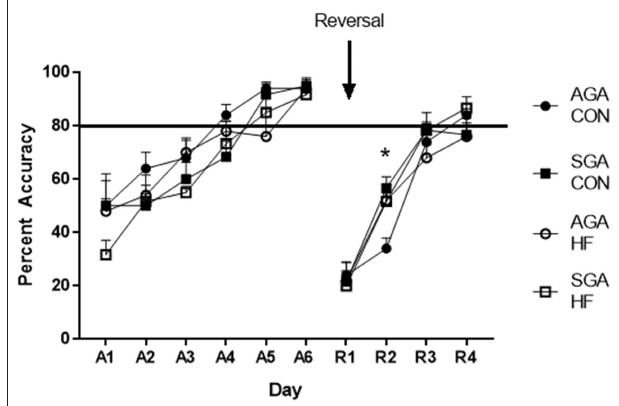
FIGURE 6 | Accuracy of SGA and AGA piglets fed CON or HF formula in a spatial T-maze task. Performance of all groups of piglets during both